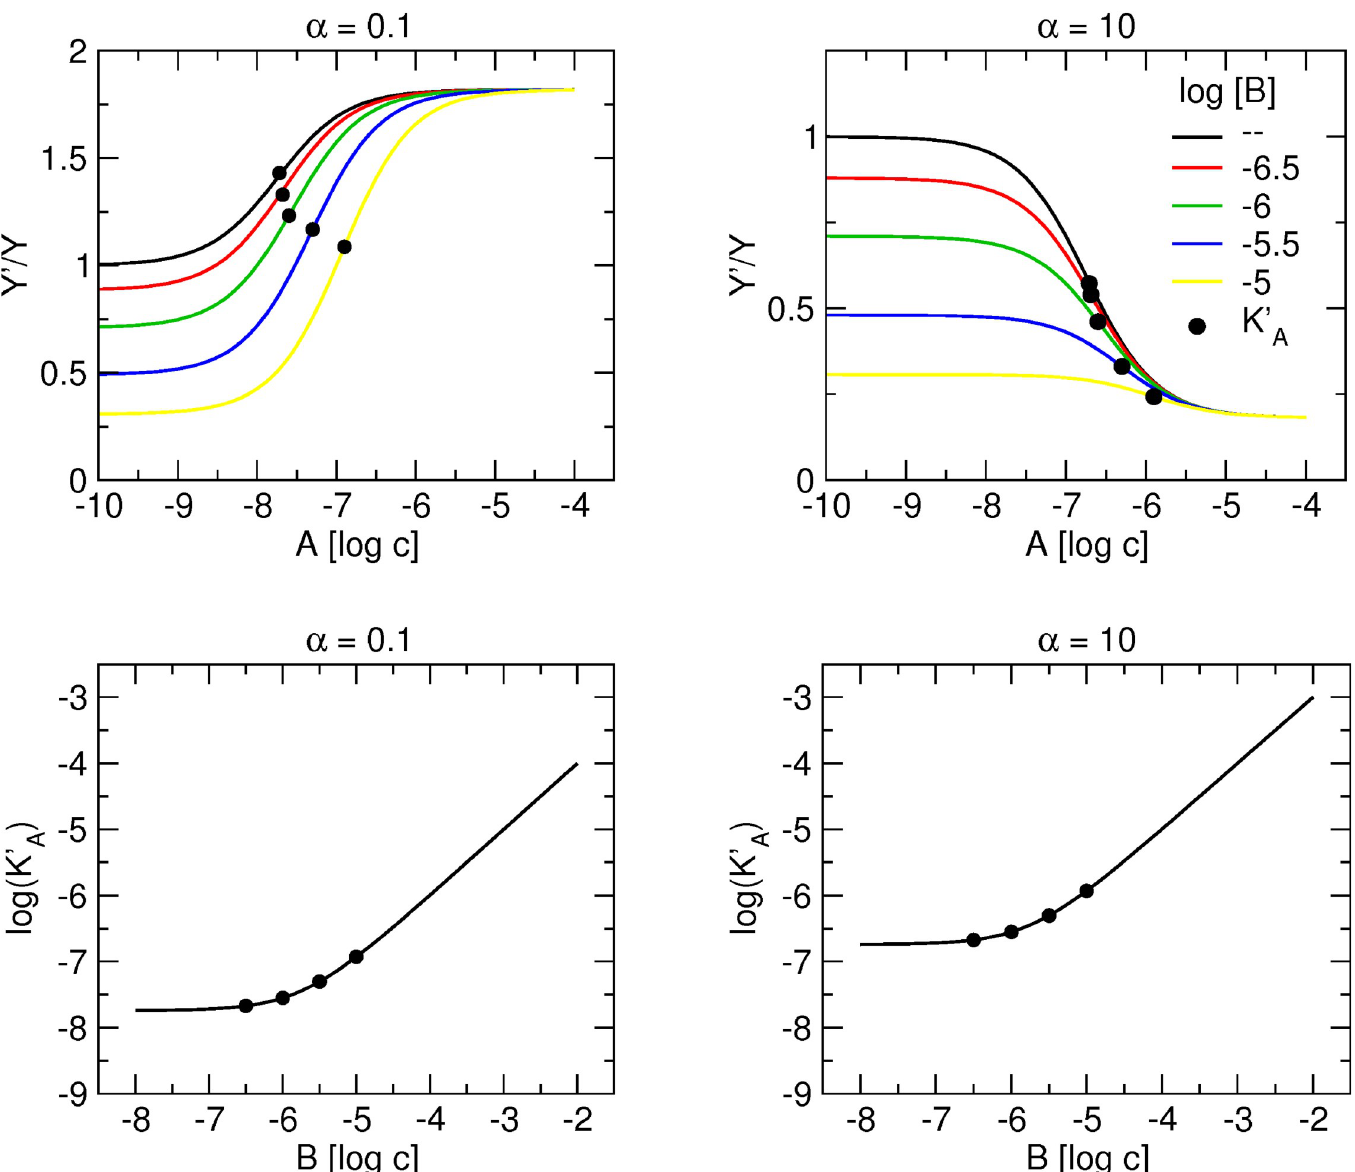
Fig 4. Concentration dependence of the interaction of two allosteric modulators that compete for the same allosteric site. Upper row, simulation of tracer binding (ordinate) in the presence of two allosteric modulators A and B competing for the same allosteric site, where α is either less than one (left) or greater than one (right) and B is negative allosteric modulator. Binding of the tracer is expressed as the ratio to the binding in the absence of allosteric modulators. Abscissa, concentration of allosteric modulator A expressed as logarithm of molar concentration. Logarithm of concentration of allosteric modulator B is shown in the graph legend. Simulation parameters: K X = 0.1 nM, [X] = 0.1 nM, K A = 100 nM, K B = 1 μ M, β = 10. Lower row, dependence of the apparent equilibrium dissociation constant of modulator A (K’ A ) on concentration of modulator